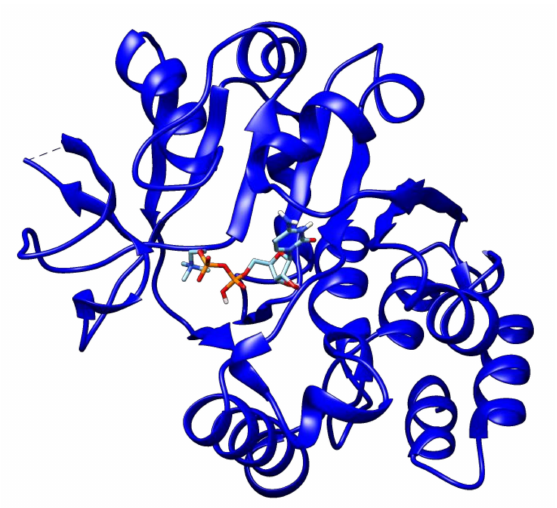
Figure 7. The docked complex of citicoline and glucose-1-phosphate